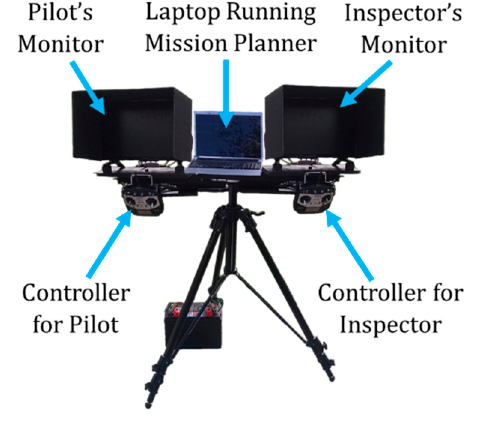
Figure 2. Ground Station used for proposed UAS.